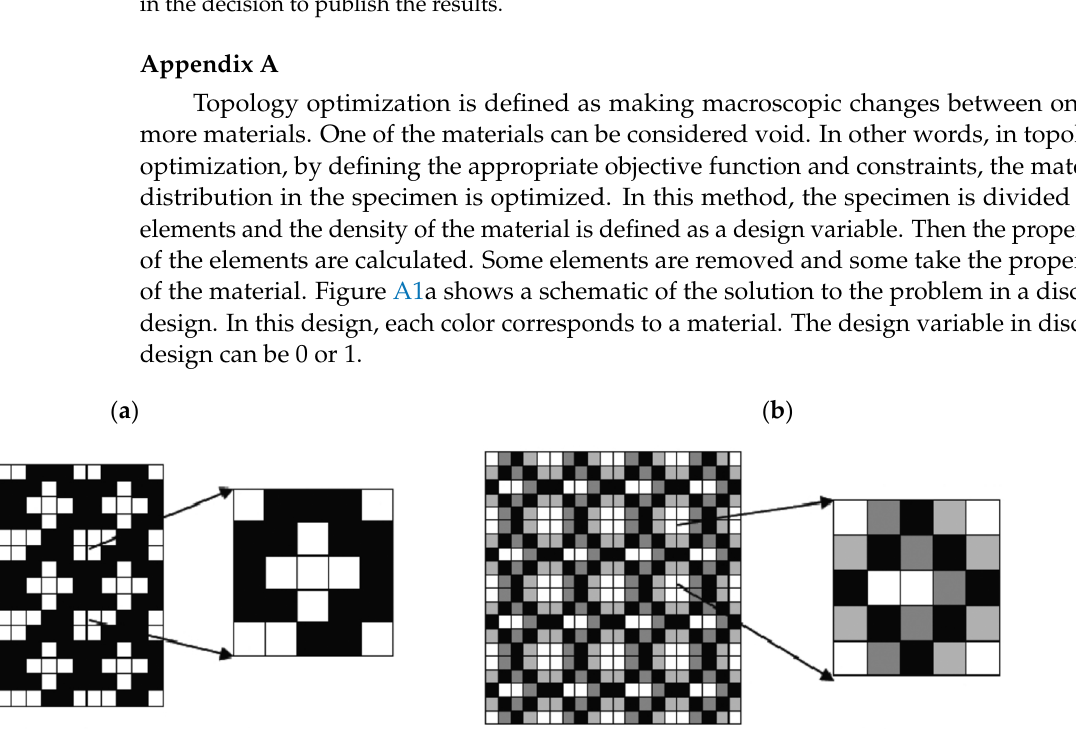
Figure A1. The topology optimization including ( a ) discrete design and ( b ) continuous design (Note: the white color is Material 1 and the black one is Material 2.) [62] .